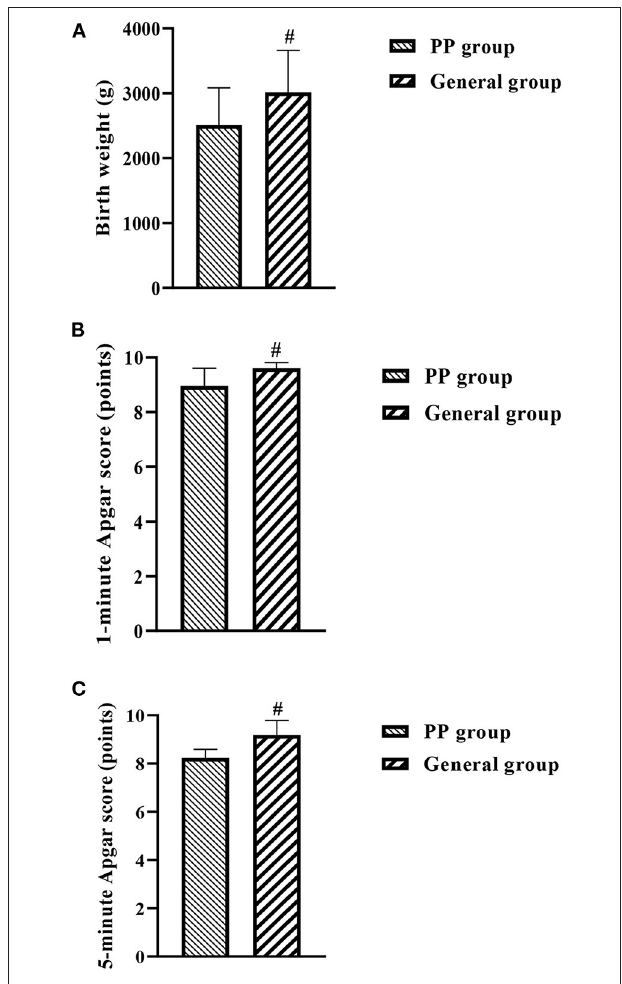
FIGURE 3 | (A–C) Histogram of neonatal conditions in both groups. # indicates comparison between two groups, P <